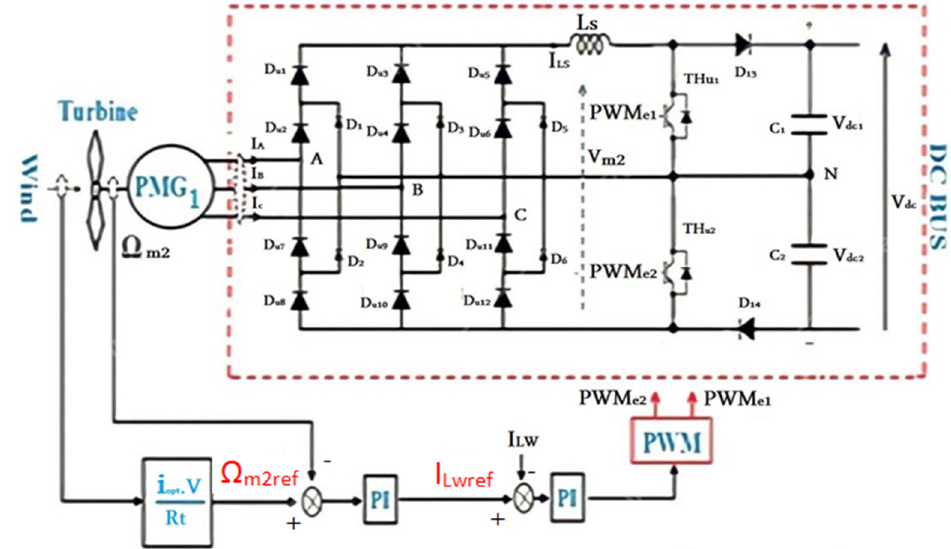
Figure 2. Wind turbine MPPT control based on the three-level boost converter. Indeed, for any operating point it is preferred to maximize mechanical power, which corresponds in Equation (1) to the maximum power coefficient Cp ( λ , β ). This maximum value is achieved if the relative speed λ reaches its optimal point ( λ opt). This technique is carried out through the speed and torque control loops of the wind turbine (through the control of current). The MPPT control techniques are presented in [18] and the wind turbine model is presented in Equation (1).